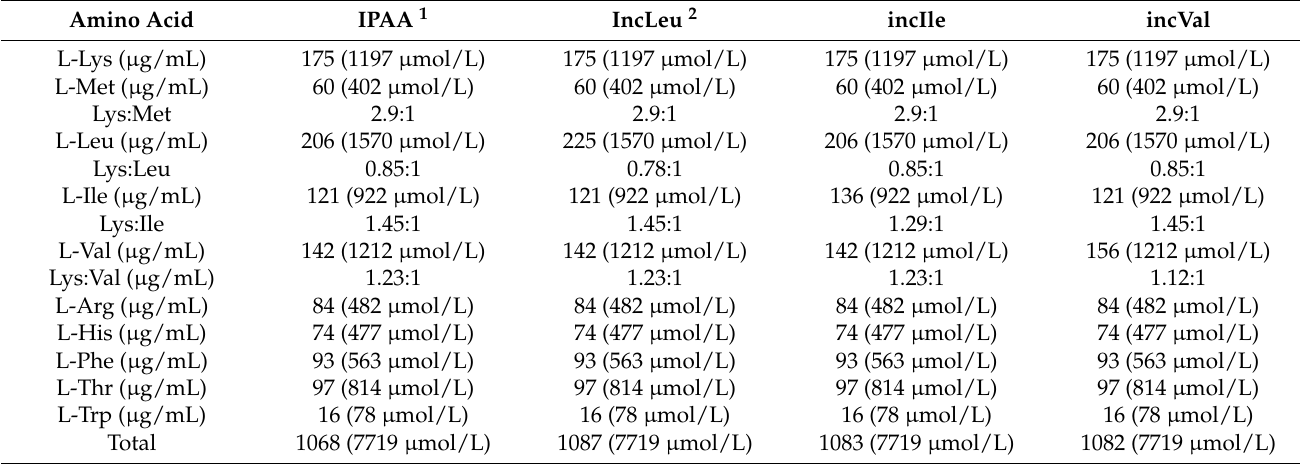
Table 1. Amino acid (AA) composition of the culture media with an ideal AA profile (IPAA; Lys:Ile ratio of 1.29:1; Lys:Val ratio of 1.12:1; Lys:Leu ratio of 0.78:1) and treatment media supplemented with greater amounts of Leu (incLeu), Ile (incIle), or Val (incVal) to alter ratios of Lys:Leu, Lys:Ile, or Lys:Val relative to